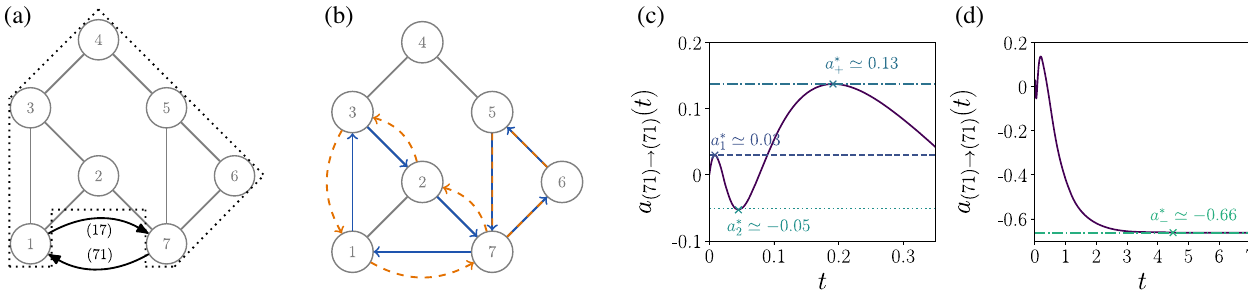
FIG. 2. Illustrative example for a partially accessible multicyclic network. (a) Effective description for a seven-state multicyclic network in which the link between state 1 and state 7 is observable, leading to five different contributing cycles C i numbered incrementally. The corresponding transition rates are given in Appendix E. For cycle C 0 ¼ ð 1271 Þ , the affinity A C vanishes; the affinity 0 of cycle C 1 ¼ ð 13271 Þ is A C ¼ 3 . 18 ; the affinity of cycle C 2 ¼ ð 134571 Þ is A C ¼ − 1 . 43 ; the affinity of cycle C 3 ¼ ð 1345671 Þ is 1 2 A 7 . 27 ; and the affinity of cycle C 1234571 Þ is given by A − 5 . 61 . (b) Example for a trimmed path. For the snippet γ t C 3 ¼ 4 ¼ ð C 4 ¼ → I I þ þ depicted with blue arrows, the sequence of visited states is (713276571). The trimmed path for this snippet is (713271) (cf. the algorithm in the main text). The corresponding γ t I is not the reversed sequence but rather (176572317) and depicted with dashed orange − → I − . Terms due to the extra loop (7567) cancel in this path arrows. Thus, the associated cycle is C 1 , i.e., P ½ γ t I j I (cid:2) = P ½ γ t I j I − (cid:2) ¼ A C → I þ 1 − → I − þ þ weight quotient. (c),(d) Estimation of the cycle affinities of the contributing cycles based on the extreme values of a ð t Þ . The ð 71 Þ → ð 71 Þ ≃ 0 . 13 and the minimal value a (cid:5) ≃ − 0 . 66 of a maximal value a (cid:5) ð t Þ are lower and upper bounds for the maximal affinity − ð 71 Þ → ð 71 Þ þ A 7 . 27 and the minimal affinity A − 5 . 61 , respectively. The initial value a ð 0 Þ ¼ a (cid:5) 0 ¼ 0 equals the affinity A C ¼ 0 of C 3 ¼ C 4 ¼ ð 71 Þ → ð 71 Þ 0 the shortest network cycle. The local maximum a (cid:5) 1 ≃ 0 . 03 and the local minimum a (cid:5) 2 ≃ − 0 . 05 can be identified as lower and upper bounds for the affinities A C ¼ 3 . 18 and A C ¼ − 1 . 43 of the remaining contributing cycles C 1 and C 2 , 1 2